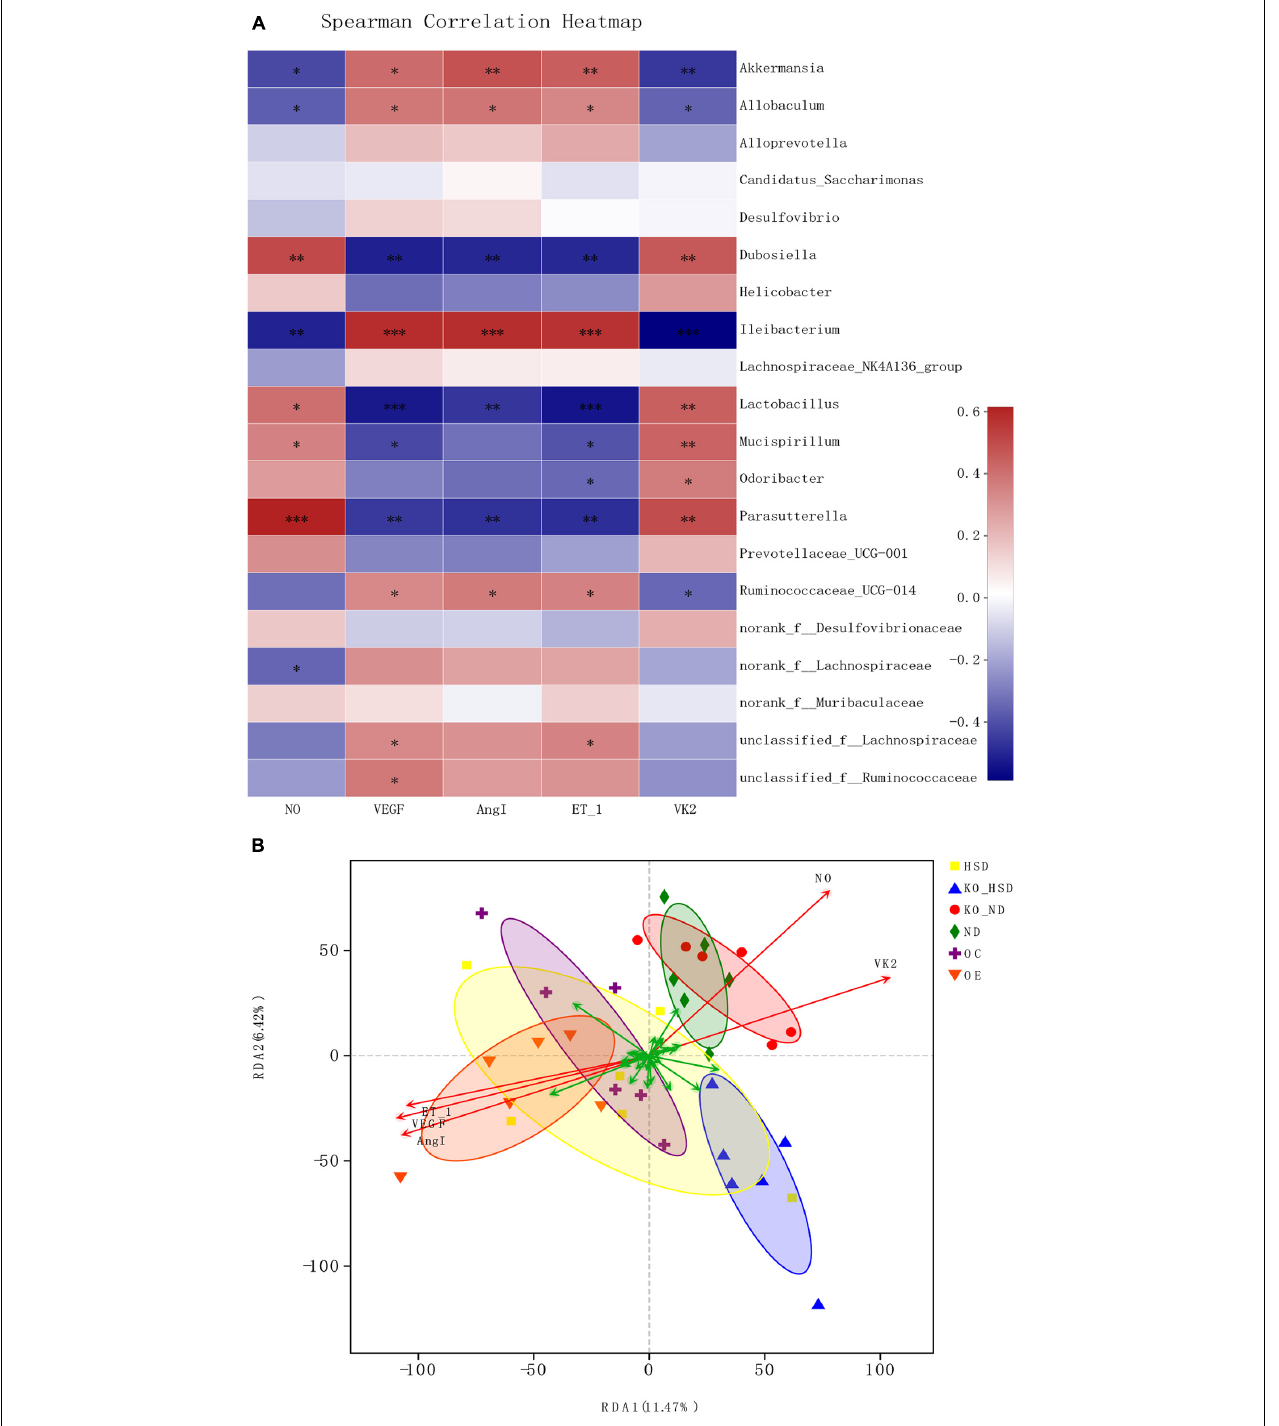
FIGURE 4 | Microbial correlation in high-salt-induced hypertensive mice. (A) Spearman correlation analysis between top 20 genera and environmental factors. Red represents positive correlation, whereas blue represents negative correlation; the darker the color, the stronger the correlation. ∗ 0.01 < p ≤ 0.05, ∗∗ 0.001 < p ≤ 0.01, ∗∗∗ p ≤ 0.001. (B) RDA analysis of environmental factors. The angle between the arrows of different environmental factors represents positive and negative correlations (acute angle: positive correlation; obtuse angle: negative correlation; right angle: no correlation). ATF4, activating transcription factor 4; KO, Atf4 ± mice; WT, wild-type mice; SBP, systolic blood pressure; NO, nitric oxide; VEGF, vascular endothelial growth factor; ANGI, angiotensin I; ET-1, endothelin-1; KO-ND, Atf4 ± mice with natural diet; KO-HSD, Atf4 ± mice with high-salt diet; ND, WT mice with natural diet; HSD, WT mice with high-salt diet; OE, Atf4 overexpression with high-salt diet; OC, Atf4 overexpression control with high-salt diet.